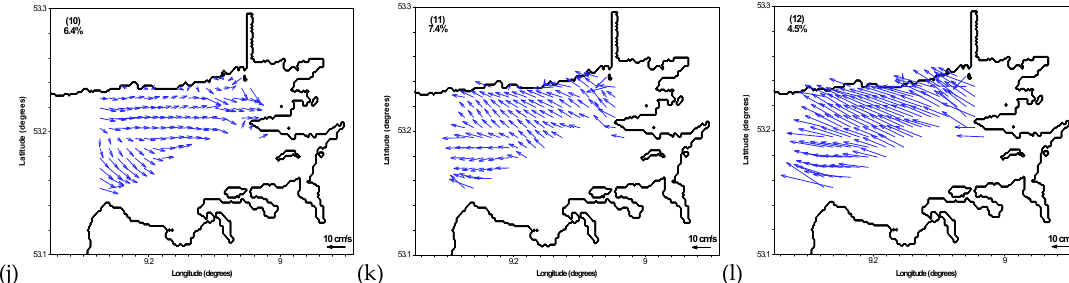
Figure 3. Characteristic spatial patterns of surface currents from model results extracted by a 4 × 3 SOM analysis (subfigures ( a – l ) indicates twelve spatial SOM patterns, respectively; the occurrence frequency is given as a percentage number for each pattern at the topleft).